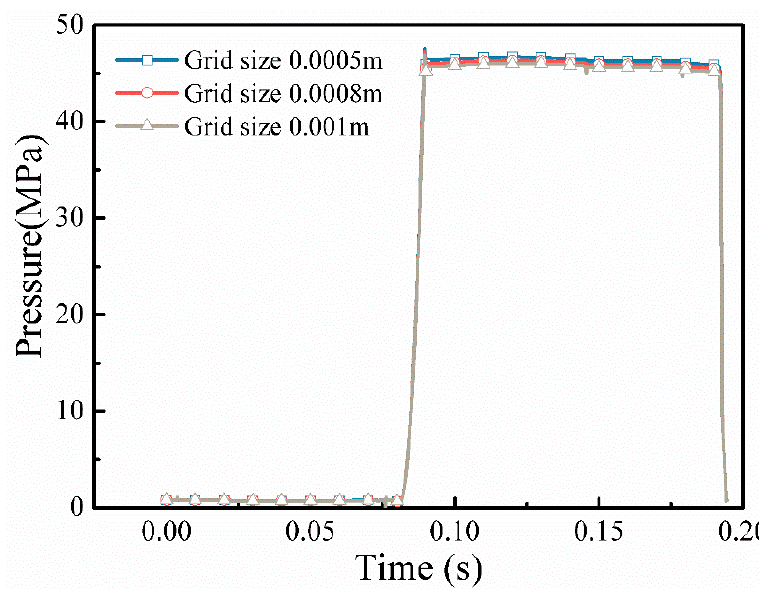
Figure 4. Grid independence verification.